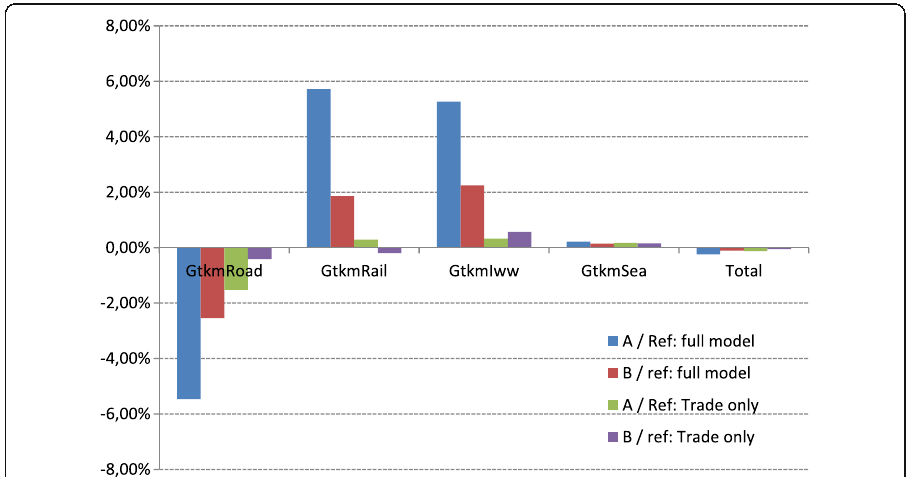
Fig. 2 Overall relative change in transport activity (tonne-kilometres) by mode for the combined trade and logistics model and for the trade model